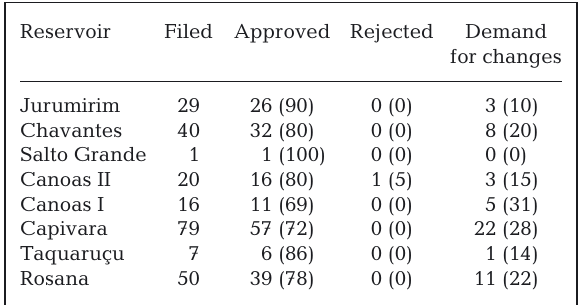
Table 3. Requests filed with the Ministry of Fishing and Aquaculture (Ministério da Pesca e Aquicultura) for licens- ing of aquaculture enterprises within artificial reservoirs of the Paranapanema River and registered between March 2004 and May 2014 at the Sistema de informação das au - torizações de uso das águas de domínio da União para fins de aquicultura (SINAU/MPA), the information system for permits of Brazilian water use for aquaculture purposes (Brazil 2014). Values in parentheses are the percentages of approved/rejected requests relative to those